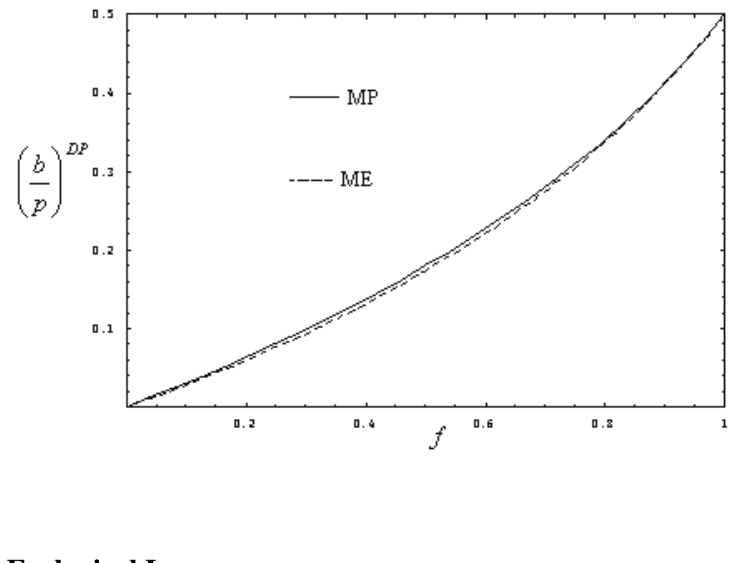
under both the maximum p 2